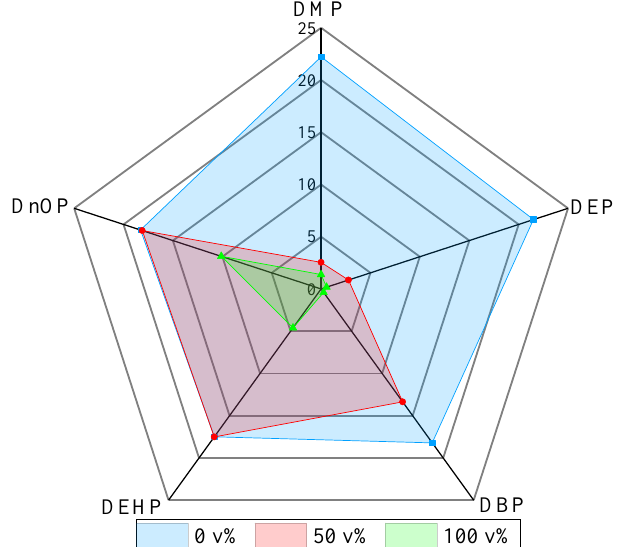
Figure 5. Equilibrium adsorption capacity values of five PAEs in systems with different